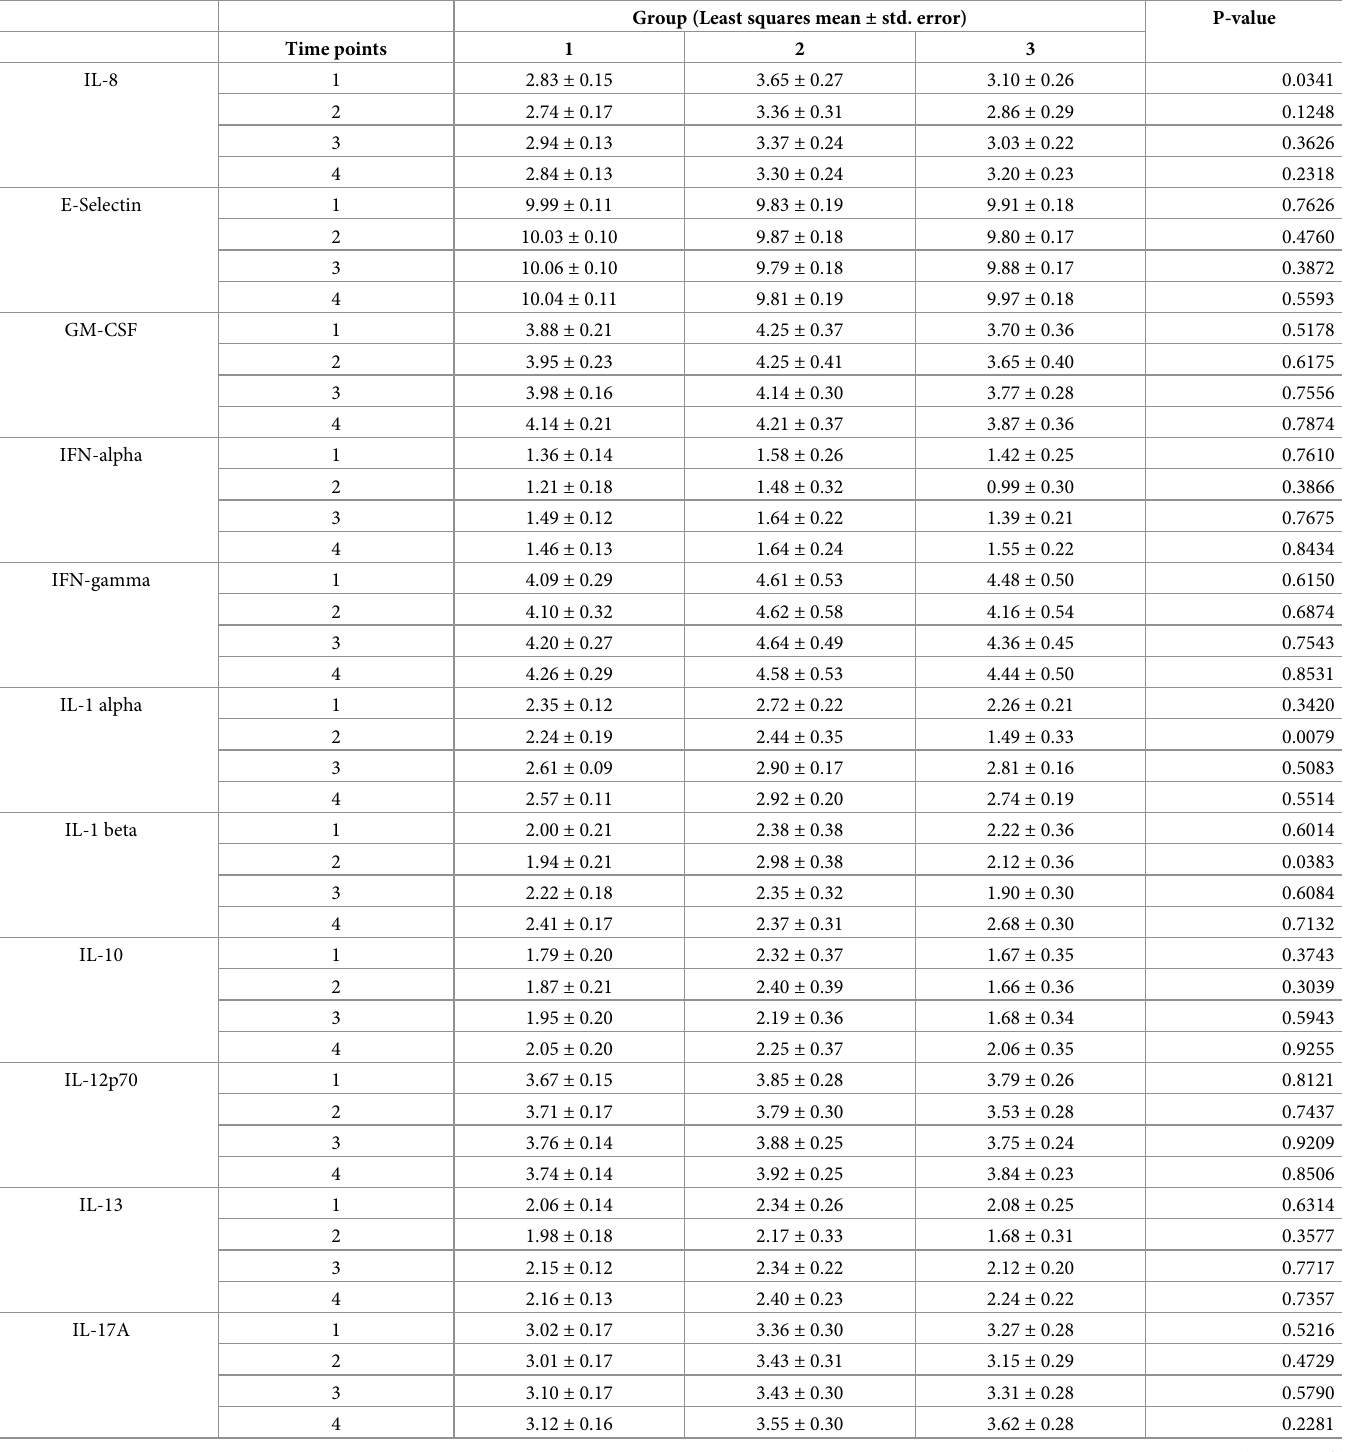
Table 3. Log-transformed cytokine levels of the three groups at different time points.